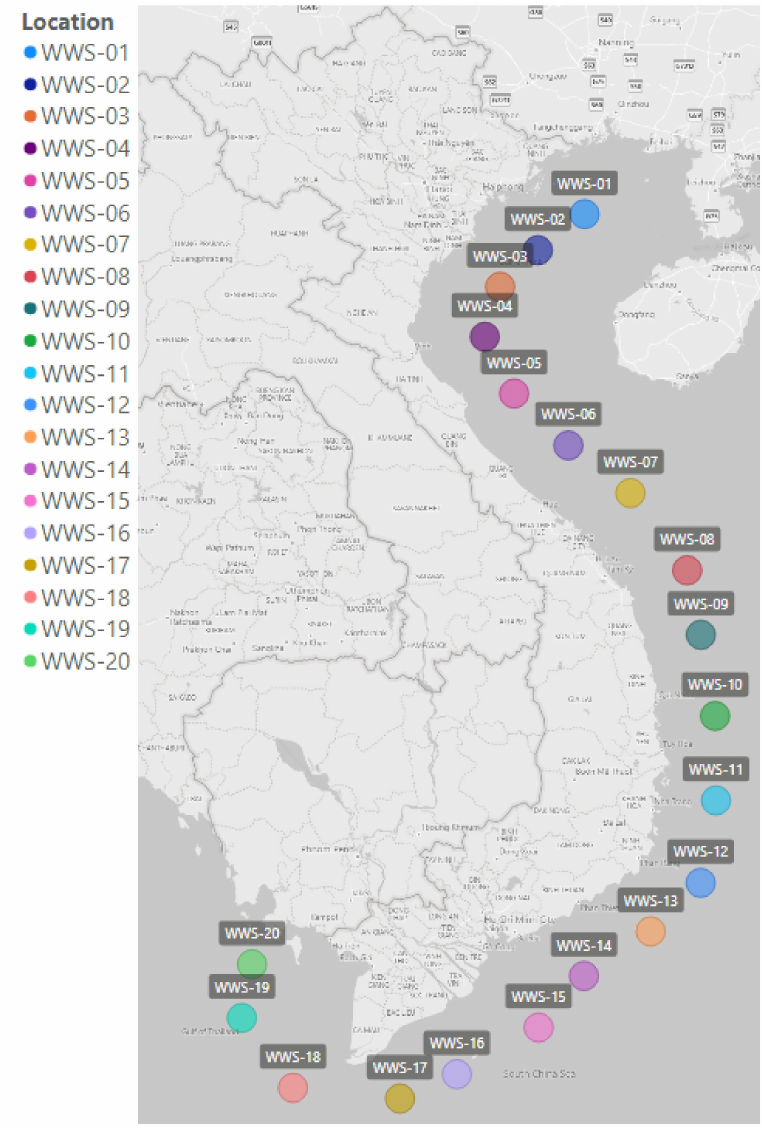
Figure 4. The proposed feasible locations for WWS in